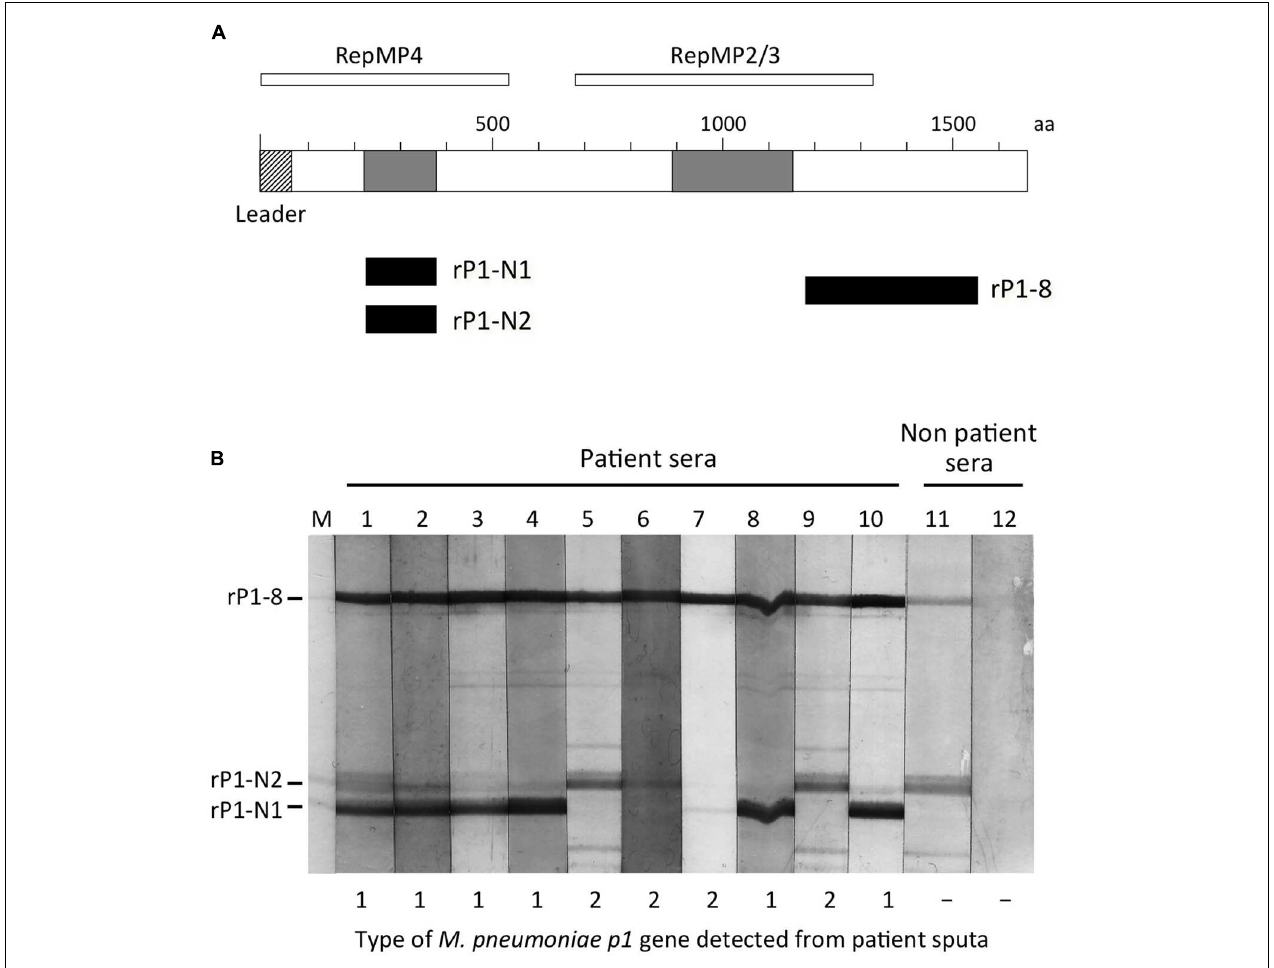
FIGURE 5 | Western blotting of the sera from M. pneumoniae pneumonia patients against recombinant P1 antigens. (A) Schematic illustration of the P1 protein structure. P1 is a 170-kDa membrane protein consisting of about 1,630 amino acids (aa) depending on the strains. The first 59 aa of this protein (hatched box) is a leader peptide, which is removed during maturation. The two gray boxes indicate polymorphic regions of P1 protein that exhibit amino acid sequence variation between type 1 and 2 strains. RepMP4 and RepMP2/3 indicate repetitive regions of the p1 gene. Multiple copies of DNA sequences similar to the RepMP4 and RepMP2/3 regions are present throughout the M. pneumoniae genome. The three filled boxes indicate the positions of recombinant P1 protein fragments produced in E. coli . The rP1-N1 region corresponds to aa 218 to 352 of the P1 protein of M129 strain (type 1). The rP1-N2 region corresponds to aa 218 to 357 of the P1 protein of FH strain (type 2). The rP1-8 region corresponds to aa 1160 to 1518 of M129 P1 (Kenri et al., 2006b). (B) Western blotting of patient sera against rP1-N1, rP1-N2, and rP1-8 recombinant proteins. Purified rP1-N1, rP1-N2, and rP1-8 proteins were separated by 10% sodium dodecyl sulfate-polyacrylamide gel electrophoresis and were blotted on a nitrocellulose membrane. Diluted (100-fold) serum samples from nine patients and two healthy subjects were reacted with the membrane. IgGs bound to the membrane were detected by alkaline phosphatase-conjugated anti-human IgG secondary antibody. The positions of recombinant P1 protein fragments are shown on the left. Lane M: Coomassie Brilliant Blue stain of the blotted membrane; lanes 1–10: patient sera (serum samples of lanes 5 and 9 were obtained from the same patient in an interval of 1 week); lanes 11 and 12: serum from healthy subjects. Types of p1 genes detected by the nested PCR method (Kenri et al., 2008) from the sputum of same patient are shown on the bottom. The analyses of serum and sputum samples were performed as a part of previous studies (Yamazaki et al., 2006; Kenri et al.,